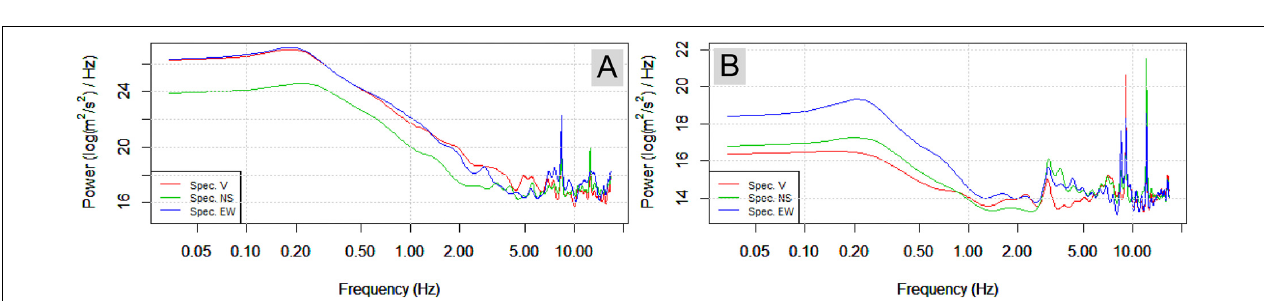
FIGURE 2 | (A) Map showing the location of 56 microtremor measurements marked by blue inverted triangles. The inset shows a map of Indonesia and Lombok Island. (B) Instruments used in microtremor data collection at MM077. (C) Installation and setup of microtremor data collection.